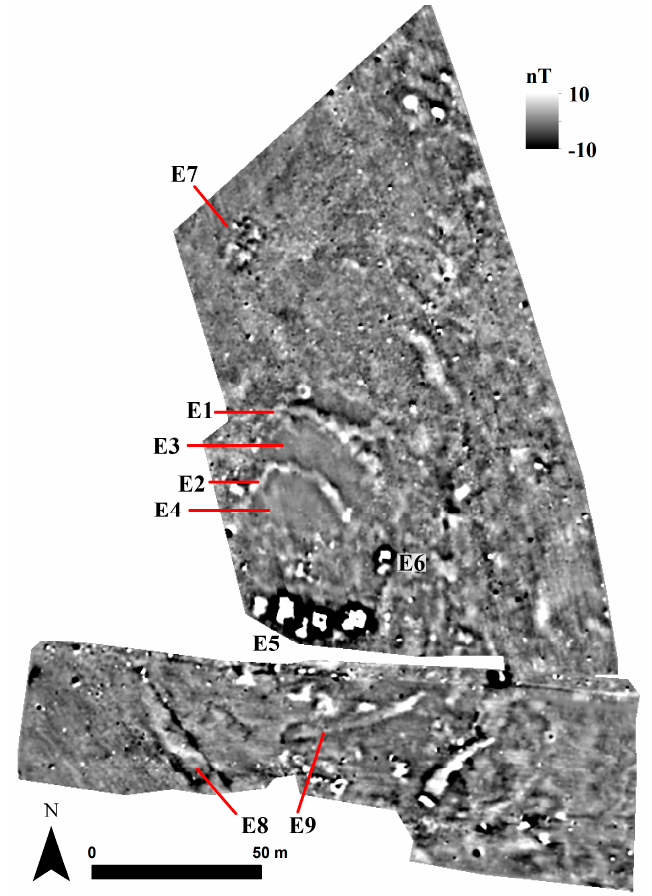
Figure 20. Geomagnetic prospection results from Perivlepto/Kastraki 2.